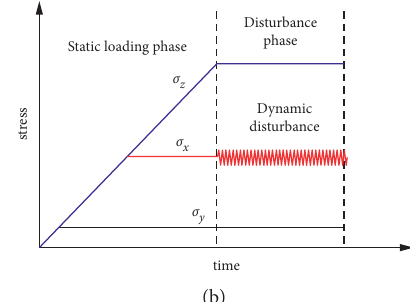
Figure 17: Mechanical analysis of rockburst simulation test for deep-buried tunnel: (a) the stress situation of tunnel free face; (b) the loading stress path